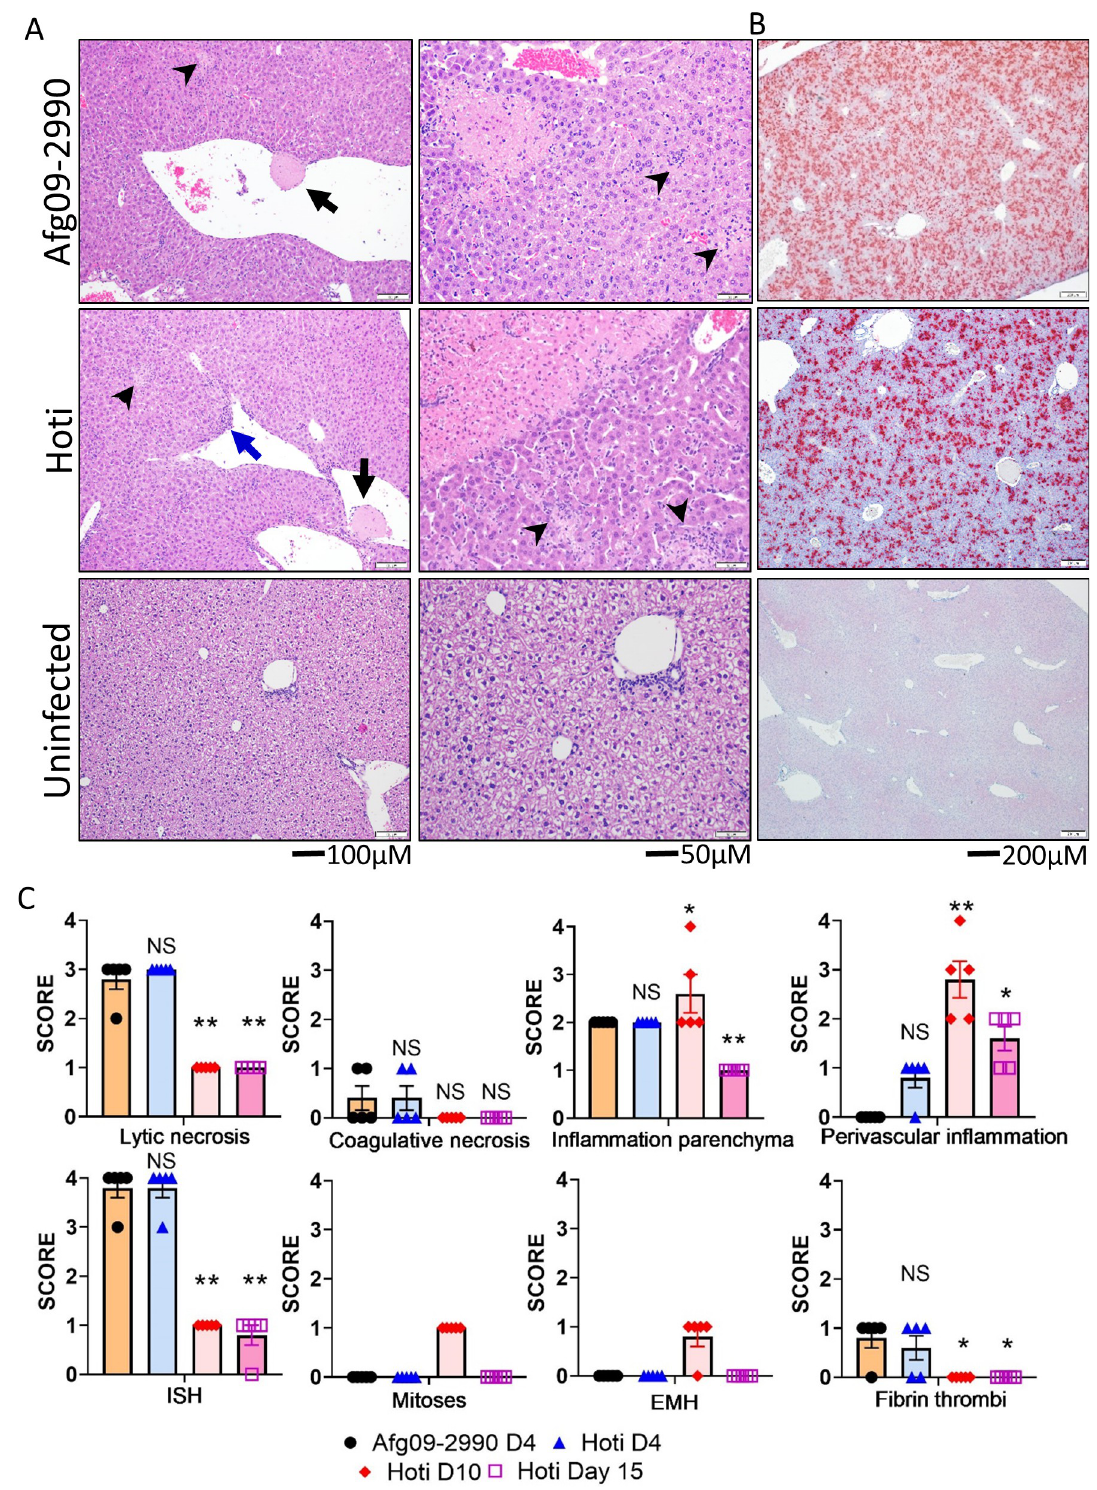
Fig 8. Liver lesions produced by CCHFV strain Afg09-2990 and strain Hoti. Representative H&E ( A ) and ISH ( B ) staining of livers Afg09-2990 and Hoti infected mice or uninfected animals as indicated. Both Afg09-2990 and Hoti infected livers have fibrin thrombus in a central vein (black arrows) as well as multifocal areas of necrosis (arrowheads). In Hoti infected, but not as much in Afg09-2990, we noted liver mononuclear inflammation adjacent to the portal vein (blue arrow). 20X panels show of coagulative necrosis at